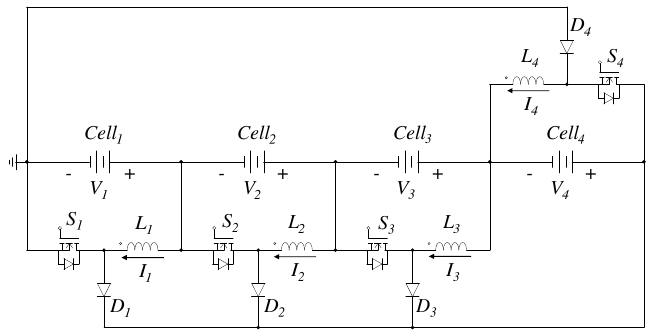
Figure 32. Buck-boost converter-based